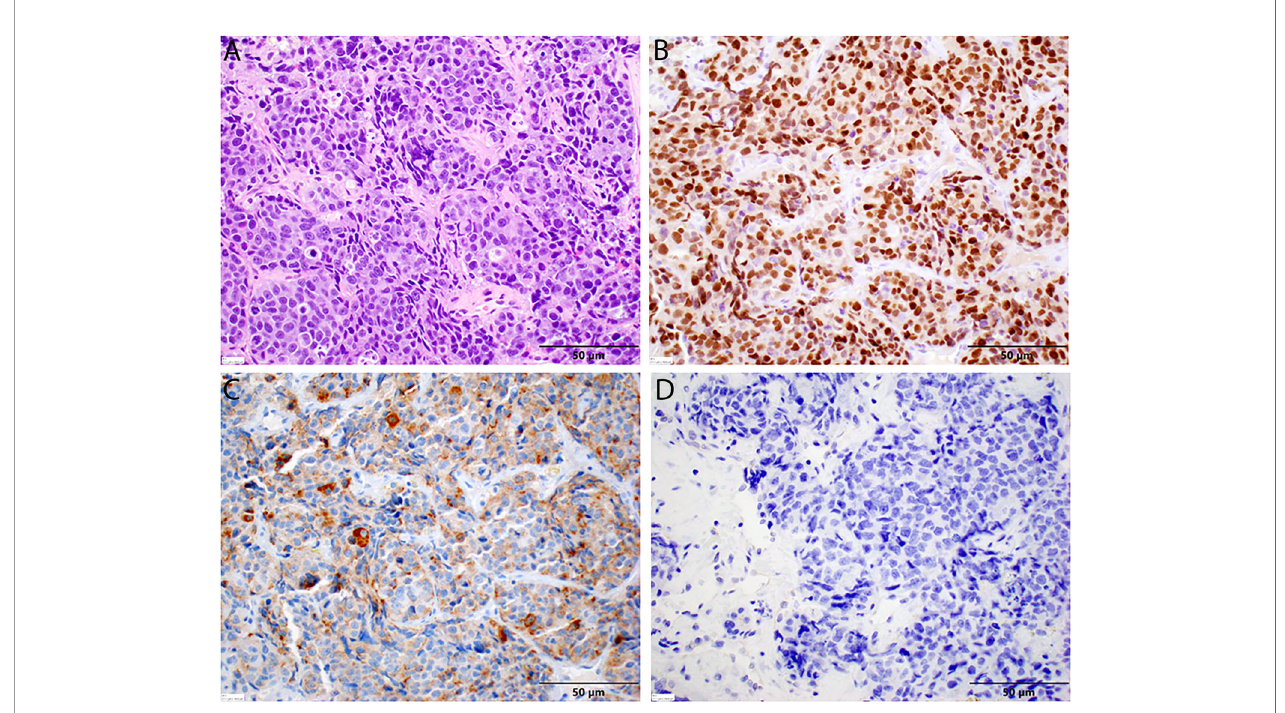
FIGURE 4 | Histopathology of second liver biopsy. (A) Metastatic prostate adenocarcinoma displaying similar features to the previous sample, including signi fi cant nuclear enlargement and pleomorphism, prominent nucleoli, mitotic fi gures, and single-cell necrosis in this representative fi eld. Again, note the absence of neuroendocrine features [H&E stain, 40× magni fi cation]. (B) Diffuse nuclear positivity with NKX3.1 in tumor cells [NKX3.1 stain, 40× magni fi cation]. (C) Diffuse cytoplasmic positivity with PSA in tumor cells. (D) No cytoplasmic staining with chromogranin in tumor cells [chromogranin, 40× magni fi